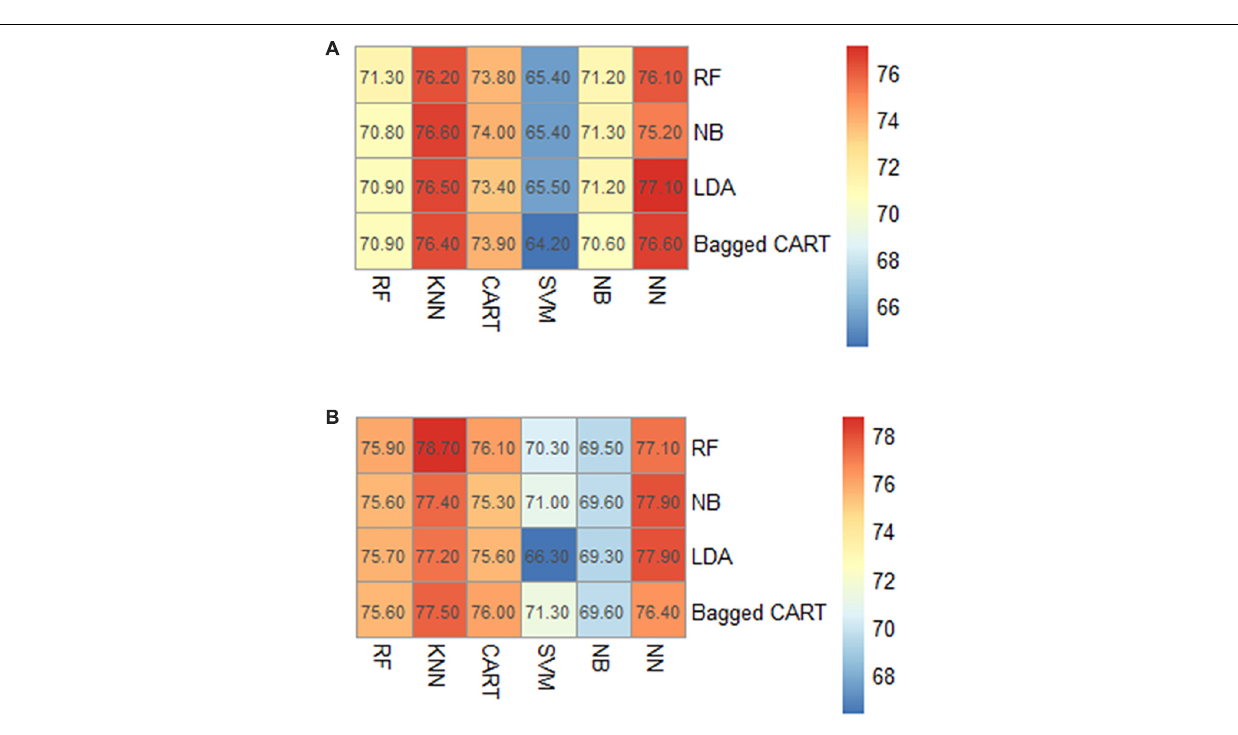
Table 2 ). In the prediction results of the anti- E. coli